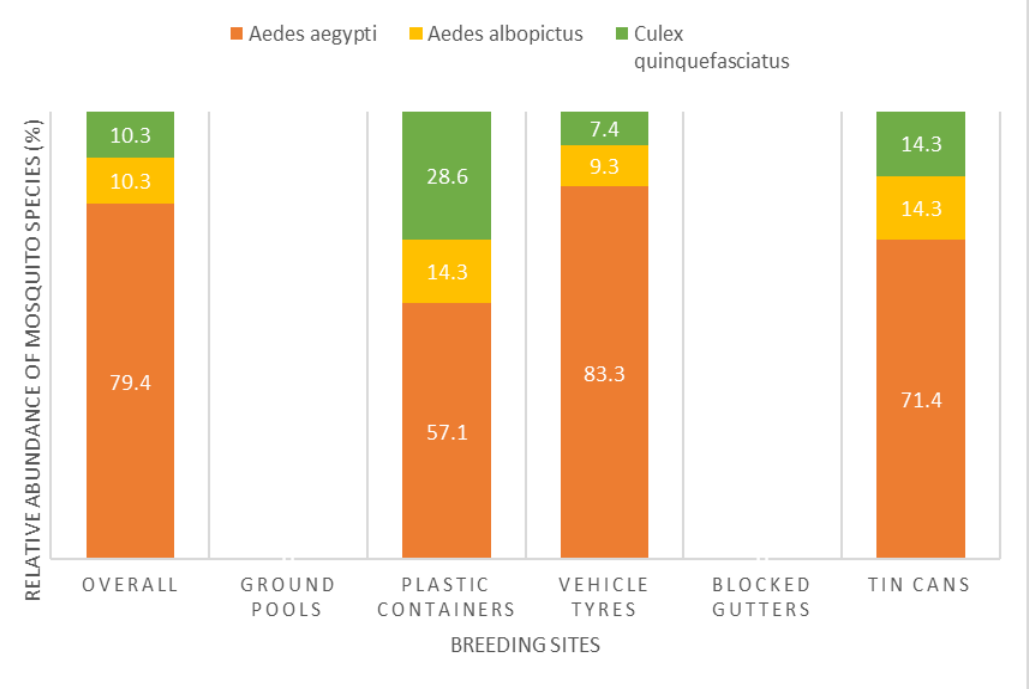
Figure 3. Relative abundance of mosquito larvae collected across different breeding